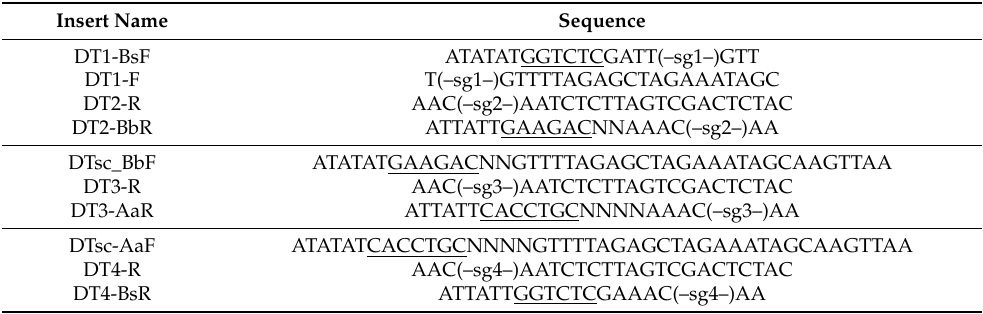
Table 1. List of primers and sequences for the pHEE401E_UBQ_Bar